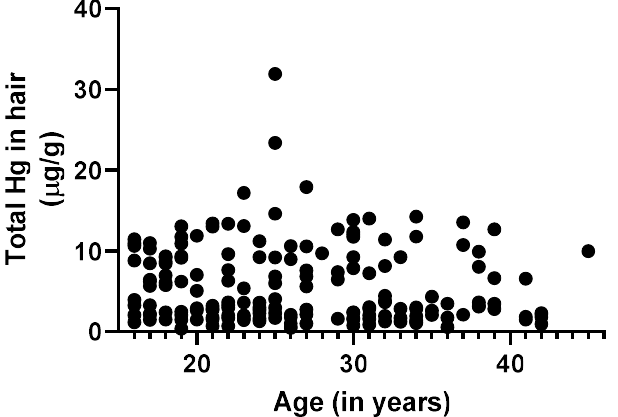
Figure 3. Scatterplot of participants’ age in years and concentrations of total mercury in hair. This included 178 participants. Total Hg concentrations in hair were not significantly correlated with age (r = −0.10, 95% CI −0.25–0.05, p = 0.16).